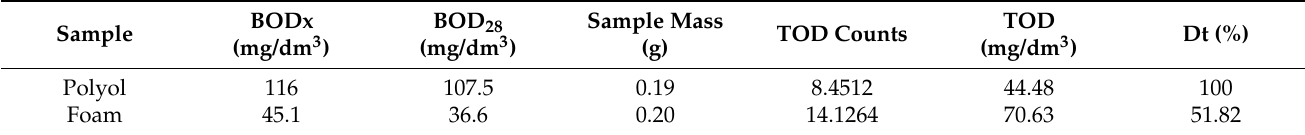
Table 11. Results of susceptibility to biodegradation of polyol and